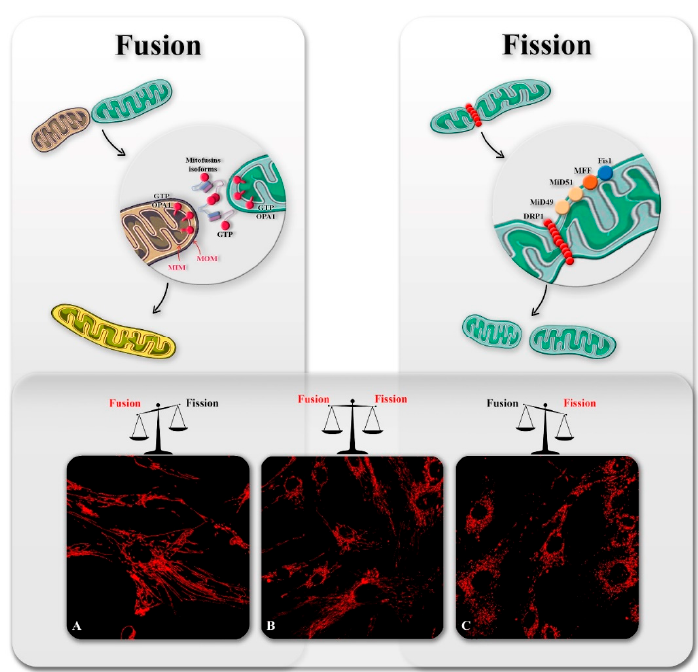
Figure 1. Mechanism and regulation of mitochondrial dynamics. Mitochondrial fusion (upper left panel) is mediated by large dynamin-related GTPase proteins Mfn1, Mfn2, and OPA1. Mitochondrial outer membrane (MOM) fusion is mediated by Mfn1 and Mfn2, whereas mitochondrial inner membrane (MIM) fusion is mediated by OPA1. Mitochondria fission (upper right panel) requires the recruitment of Drp1 from cytosol to mitochondria. Drp1 binds to four Drp1 receptor proteins Fis1, Mff, MID49, and MID51. Below representative images of hyperfused ( A ), regular ( B ), and fragmented ( C ) fibroblast mitochondrial network.